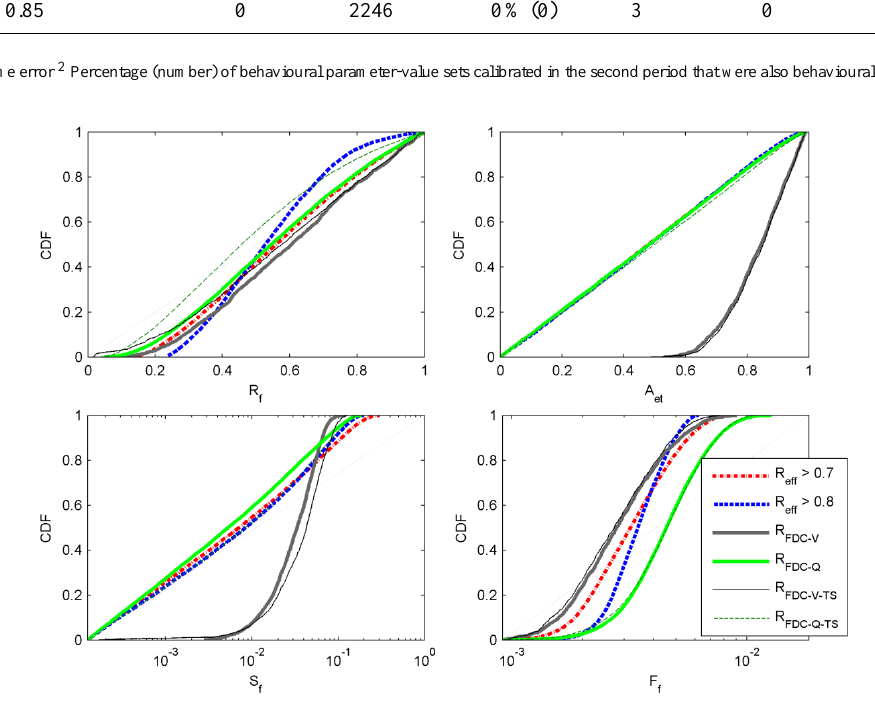
Fig. 7. Cumulative informal likelihood distributions for all WASMOD model parameters ( R f – routing of fast flow, A et – evaporation, S f – slow flow, and F f – fast flow). The informal likelihood weights for each performance measure were calculated for the calibration in 1989–1997 for R eff , R FDC − Q and R FDC − V , and for the calibration in 1989–1997 using the FDC for 1980–1988 for R FDC − Q − TS , and R FDC − V − TS in the Paso La Ceiba catchment.